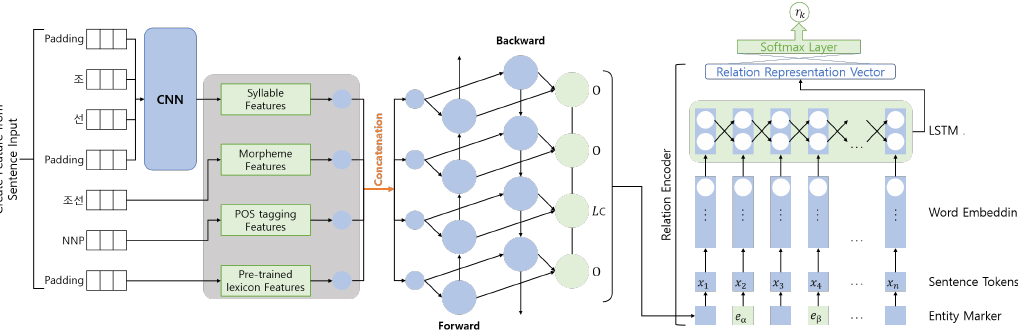
Figure 3. Long Short Term Memory(LSTM) based Mention-level ‘Local’ Relation Extraction